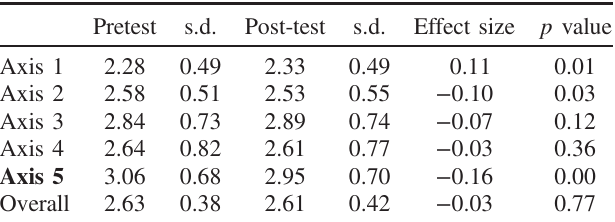
TABLE III. Modified spring pretest and post-test results by EBAPS axis.